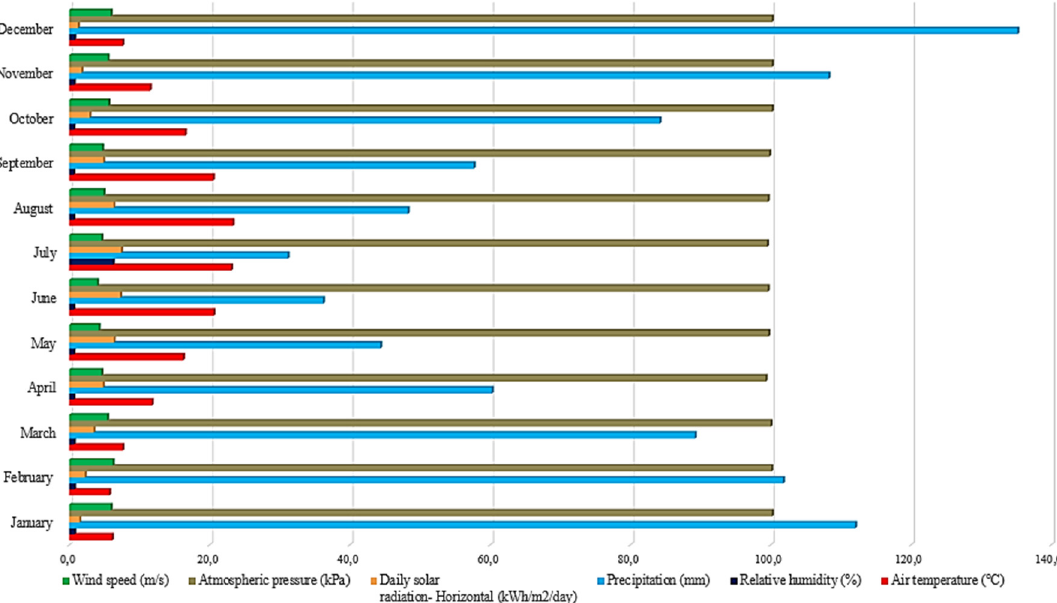
Figure 3. The drawn chart of climate data in [28] for the current location.